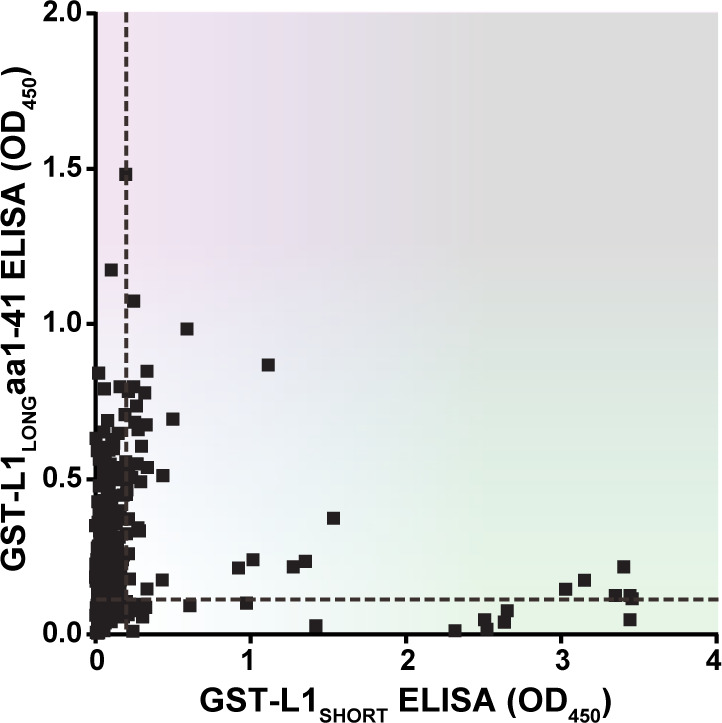
Additional correlation of seroreactivities measured by GST-ELISA.Correlation of GST-L1SHORT with GST-L1MIDDLE (R2 = 0.0106). Dashed lines indicate the cut-offs (OD450 = 0.2 for GST-L1SHORT, GST-L1MIDDLE and GST-L1LONG; OD450 = 0.11 for L1LONGaa1-41).